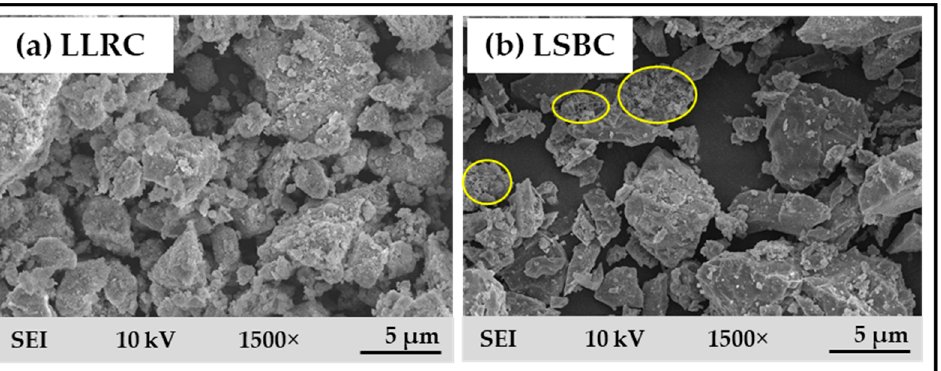
Figure 2. SEM micrographs of raw materials at 1500× magnification: ( a ) Lanao Linamon Red Clay (LLRC); ( b ) Lanao Salvador Black Cinder (LSBC) with yellow insets showing the platy structures.